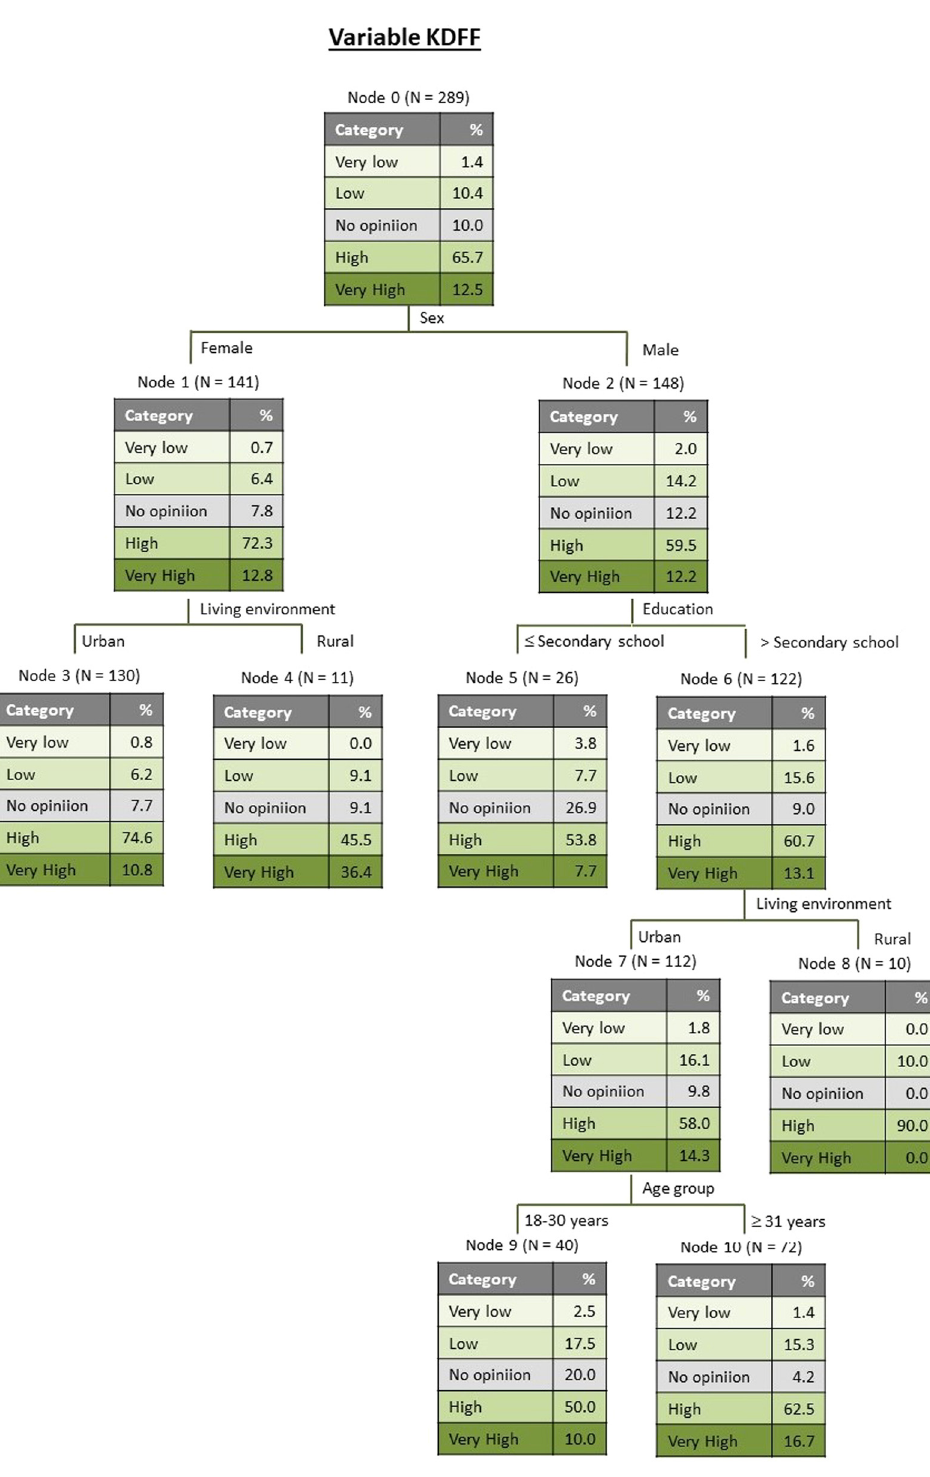
shows that that the best predictor for KDFF was gender, followed by living environment for the women or education for the men. This classi fi cation tree had an estimated risk of 0.343 with standard error of 0.028 for